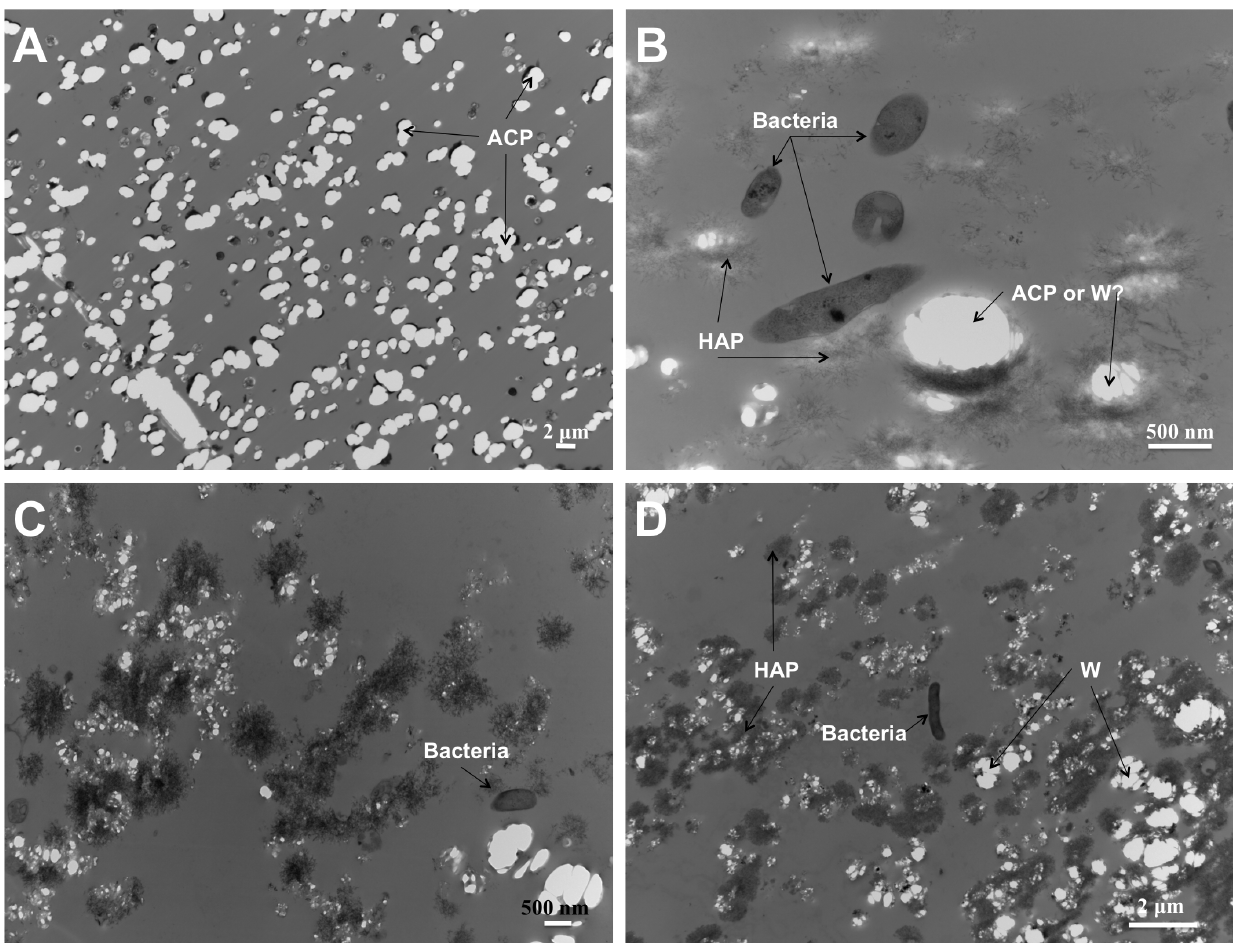
Figure 9. TEM imaging of solids identified in sterile and inoculated DSMZ media. (A) Sample recovered from the sterile DSMZ medium after 15 days of aging. ACP granules embedded in resin are visible. (B, C, D) Images from samples recovered after 3, 8 and 15 days respectively from a time course experiment in inoculated DSMZ medium. Three solid phases are distinct and interpreted to be either amorphous CaP (ACP) or whitlockite (W) and nanocrystalline hydroxyl-apatite (HAP). Bacteria (B) are also